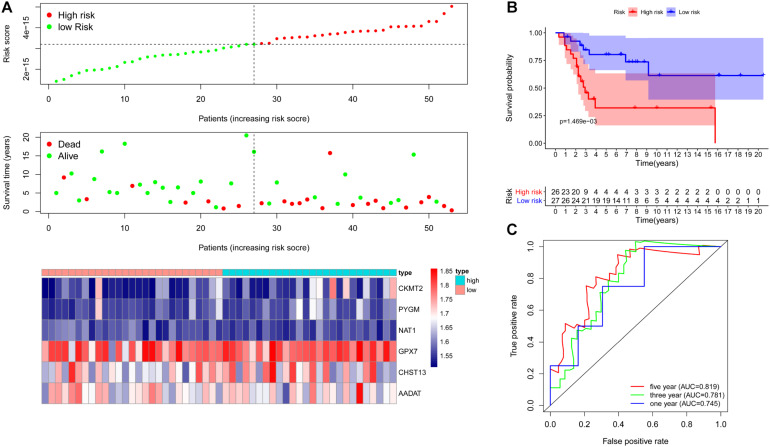
Verification of metabolic gene signature in an independent cohort. (A) Risk score distribution and survival status of OS patients based on the six metabolic genes signature and a heat map of the six metabolic genes signature expression pattern in one independent cohort (GSE21257). (B) Kaplan–Meier curves of patients in the low- and high-risk groups based on the 6 metabolic genes signature in an independent cohort (GSE21257). (C) ROC curve to evaluate 1, 3, and 5-year prediction efficiency of the six metabolic genes signature in an independent cohort (GSE21257).